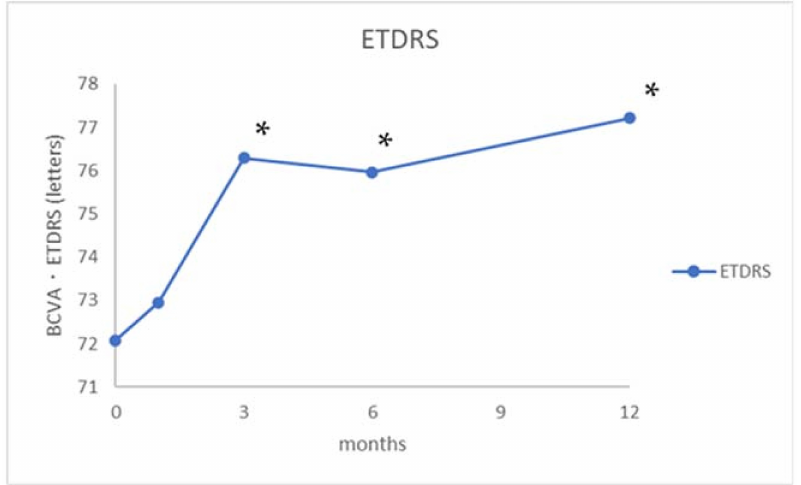
Figure 1. Changes in best corrected visual acuity (BCVA) (ETDRS: Early Treatment Diabetic Retinopa- thy Study) during the 12-month study period. * p <